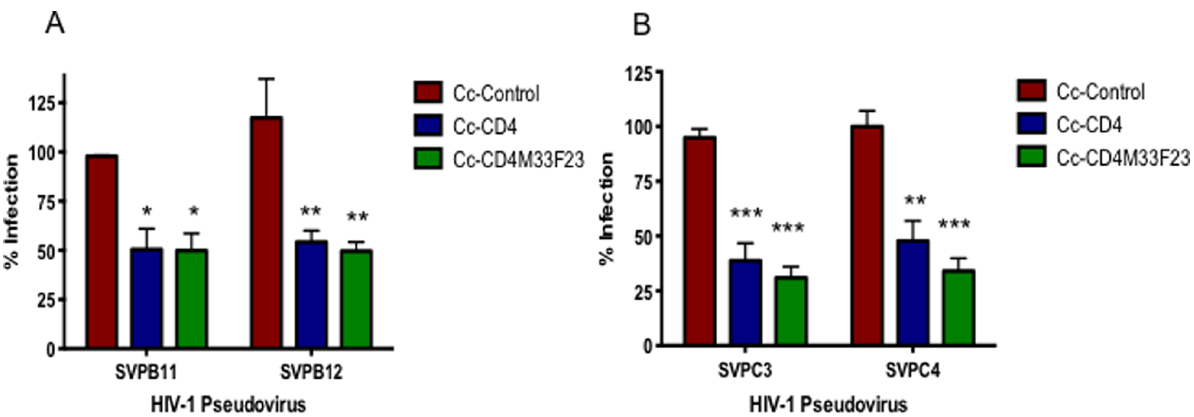
Figure 3. Viral blocking assay with Cc-CD4 and Cc-CD4M33F23. Cc-Control, Cc-CD4 and Cc-CD4M33F23 were incubated for 48 hours with TZM-bl cells and 200TCID50 clade B (SVPB11, SVPB12) or clade C (SVPC3, SVPC4) HIV-1 pseudovirus. HIV-1 infection was measured indirectly using a mammalian b -galactosidase assay. Infection rate is given as a percentage and was normalized to wells containing virus + TZM-bl cells with the background for uninfected TZM-bl cells subtracted out. The assay was set-up in quadruplicate and repeated a minimum of 3 times. *p , 0.01,